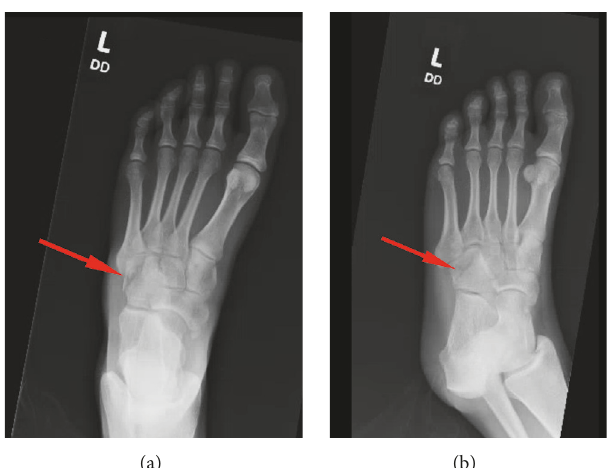
Figure 1: An X-ray of the left foot showed a commuted fracture of the cuboid bone with mildly displaced fragments, as well as moderate soft tissue edema (red